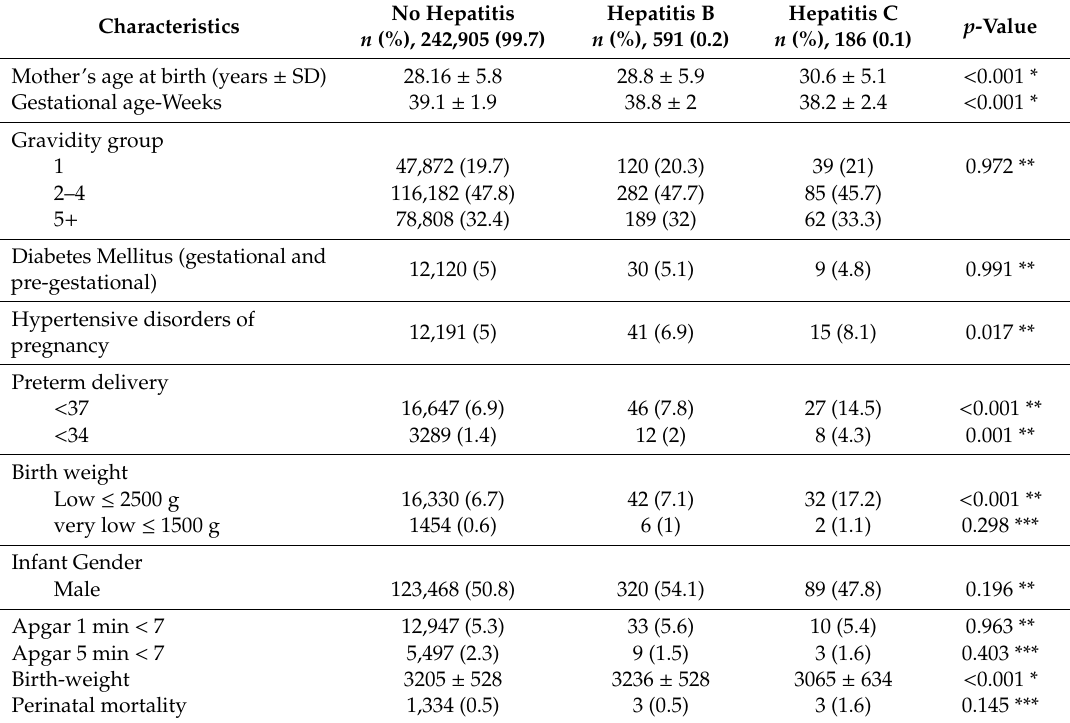
Table 1. Demographics, maternal and perinatal characteristics by study